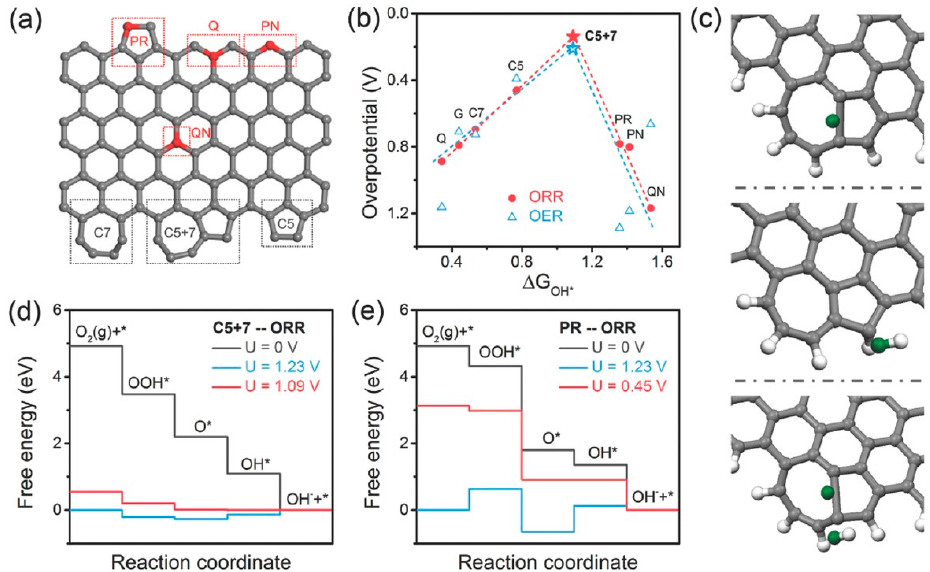
Figure 8. ( a ) Schematic illustration of various kinds of N-doping types or topological defects on graphene skeleton. (PR: pyrrolic nitrogen; PN: Pyridinic nitrogen.) ( b ) Volcano plots of overpotential versus adsorption energy of OH* for ORR and OER. ( c ) Schematic illustration of optimized adsorption mode of C5+7 interacting with O, OH, and OOH species (from top to bottom). Diagrams for showing the calculated free energy for ORR proceeded at pH = 0 on ( d ) graphene with C5+7 defect and ( e ) pyrrolic N. The color of elements: carbon (gray), hydrogen (white), oxygen (blue), and nitrogen (red). Reprinted with permission from Ref. [35], 2016 WILEY-VCH.